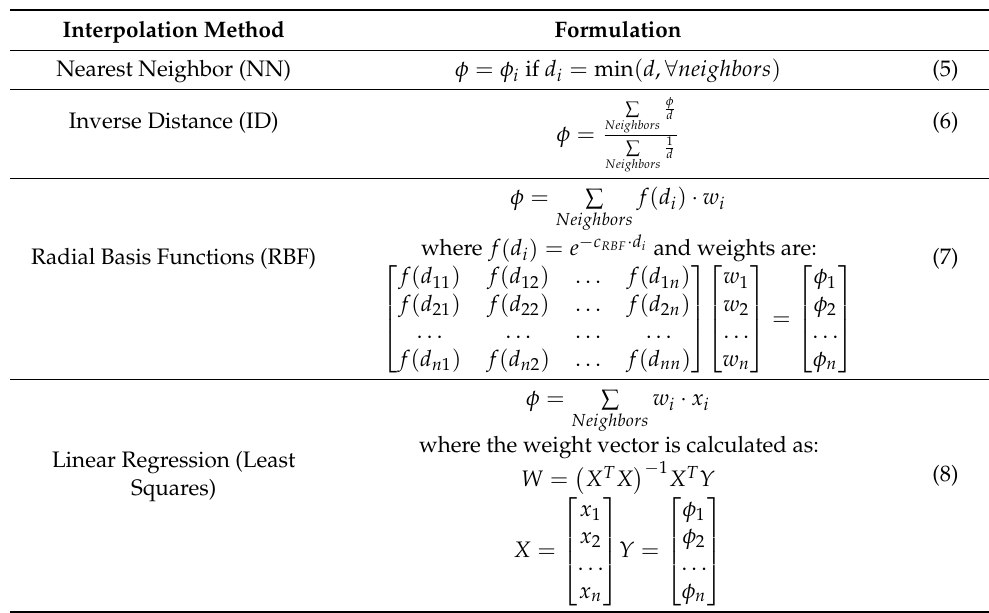
Table 1. Formulations of the different interpolation methods used in the scope of the present work. The symbol ϕ is a placeholder that stands for any interpolated quantity, e.g., velocities ( u , v , w ), or pressure, p . The symbol, d , denotes the Euclidean norm, or distance, of the location where interpolation is to be carried out from the nearby, i.e., neighboring, sampling